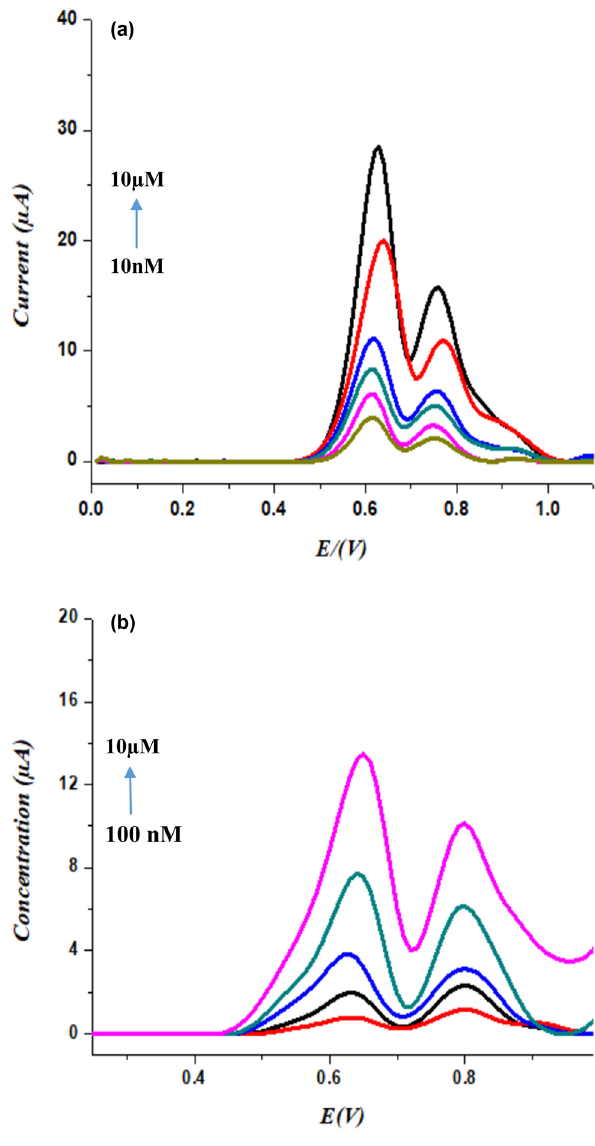
Figure 5: The obtained AdSSWVs at the GO/ β - CD modi fi ed PGE for di ff erent concentrations of SUL ( a ) in BRB solution ( pH 10.0 ) and ( b ) in urine